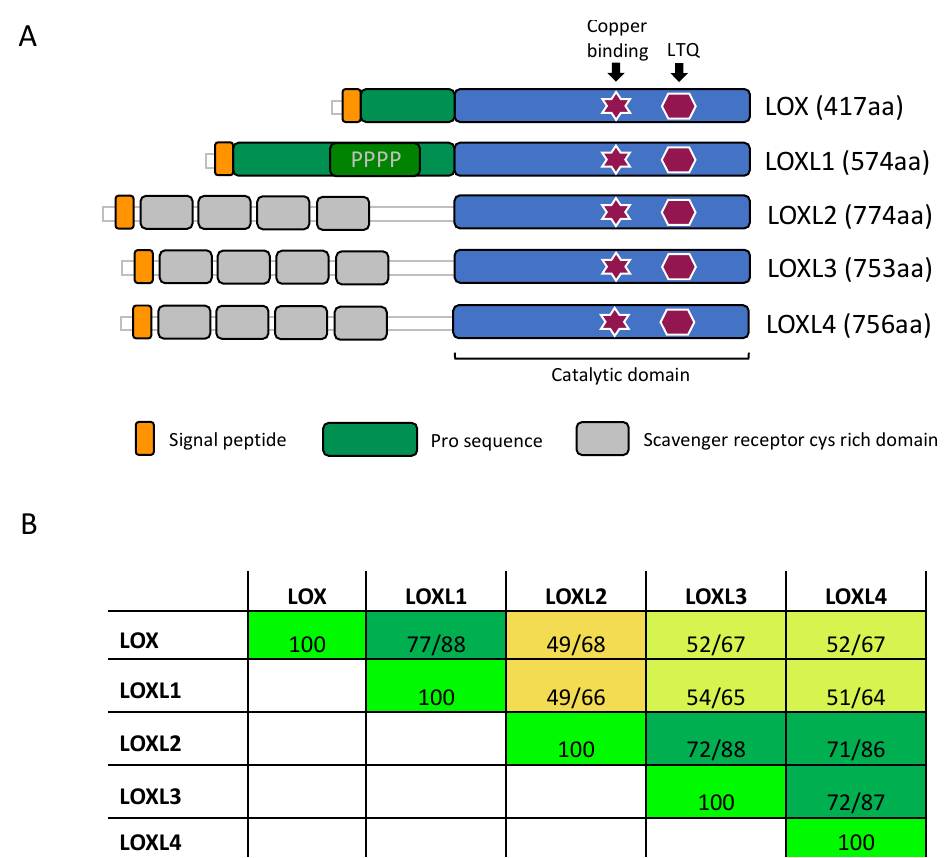
Figure 1. Domain structure and homology of the LOX enzymes. ( A ) The LOX family of proteins contains a highly conserved catalytic domain (blue) in the C-terminus. Copper binding and lysyl tyrosyl quinone (LTQ) cofactor are required for proper protein conformation and catalytic activity. The enzymes diverge more in the N-terminus. Here, LOX and LOXL1 contain a pro-sequence (green), which is cleaved off in the ECM, releasing the active enzyme. LOXL2, LOXL3 and LOXL4 contain four scavenger receptors cysteine rich (SRCR) domains (grey). (PPPP = Proline-rich domain). ( B ) Amino acid comparison of the catalytic domain of LOX (AA: 213–417), LOXL1 (AA: 370–574), LOXL2 (AA: 548–751), LOXL3 (AA: 529–732), and LOXL4 (AA: 533–736). Numbers highlight the sequence identity (1st number) and sequence homology (2nd number). The color code indicates the degree of identity.